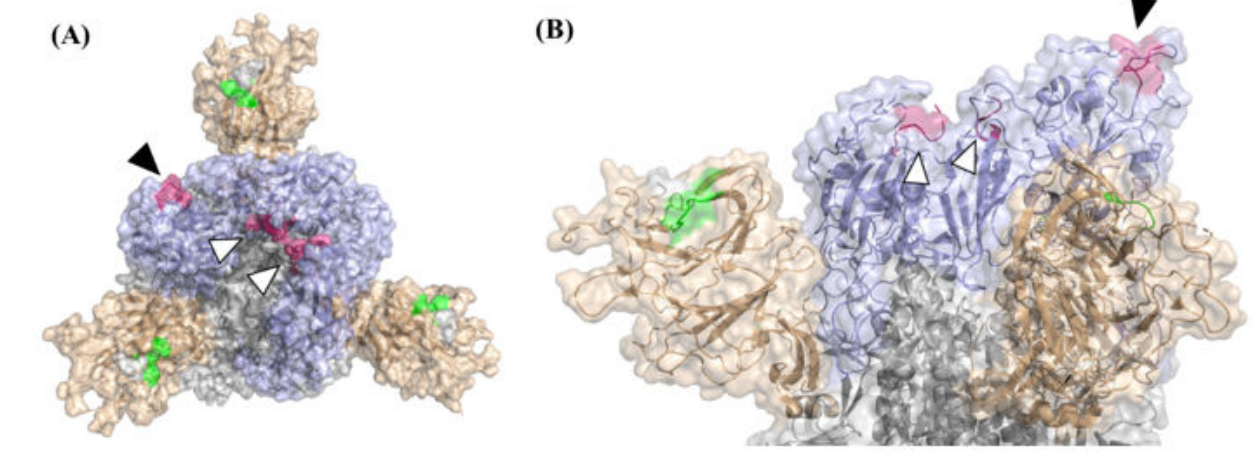
Figure 3. Spatial localization of the two most abundant cross-variant peptides on the spike trimer. Top ( A ) and side ( B ) Semi-transparent surface view of SARS-CoV-2 spike trimer (PBD 7C2l stripped off the 4A8 antibody). The N-terminal domain (NTD) is brown-colored and the receptor binding domain (RBD) is shown in purple. Other parts of the spike are colored in gray. The spatial local- ization of epitope 134QFCNDF139 is shown in green and epitope 501NGVGYQP507 is highlighted in dark pink. Black arrows mark the surface exposed epitope (when the RBD assumes the “up” position) and black-framed white arrows mark this epitope within the “closed” inaccessible po- sition of the RBD. All analyses were performed by using the PyMol Molecular Graphics System (Version 1.7 Schrödinger, LLC (Portland, OR,